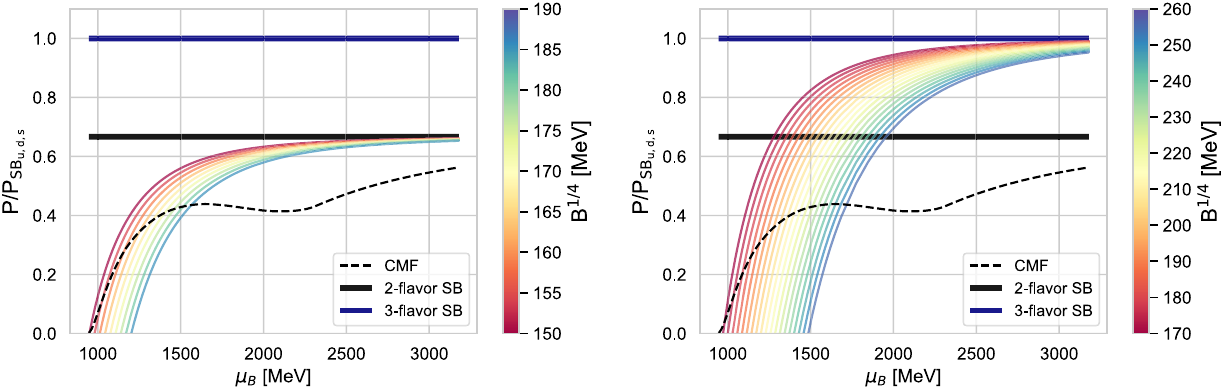
Fig. 3 Equationsofstateforthe2-flavor(left)and3-flavor(right)Bag- CMF model. The dashed black line is the EoS obtained from the CMF model. The colored lines show the MIT Bag EoS with different Bag